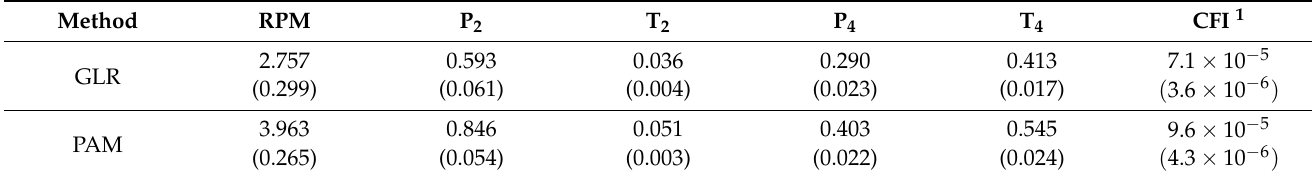
Figure 4. Simulation results: FD and FTC of the RPM sensor fault: ( a ) fault estimation; ( b ) FDI using test statistics; ( c ) control reconfiguration; ( d ) RPM in the SMC loop; ( e ) response in the sensor (P 4 ); ( f ) response in the sensor (T 4 ). Table 1. Estimation performance measure J est